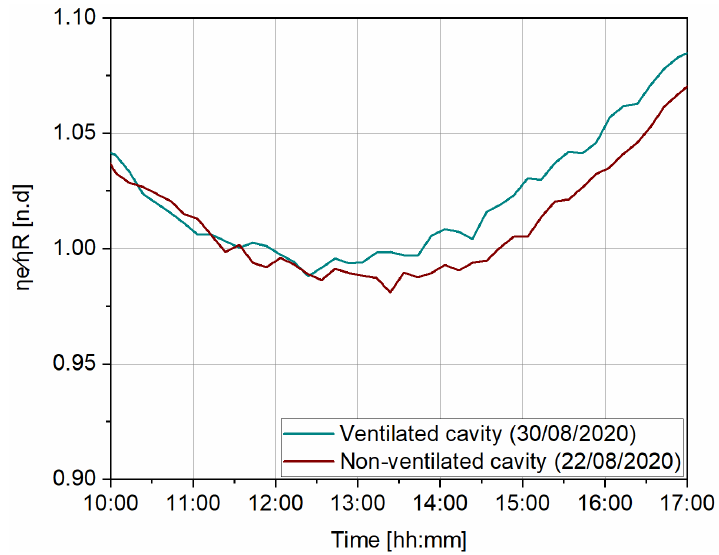
Figure 15. BIPV-WS electrical efficiency behavior for summer conditions.